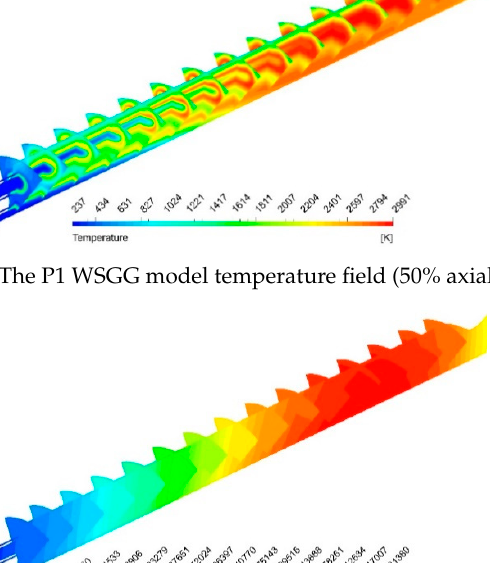
Figure 15. The WSGG model radiation intensity (50% axial scaling).